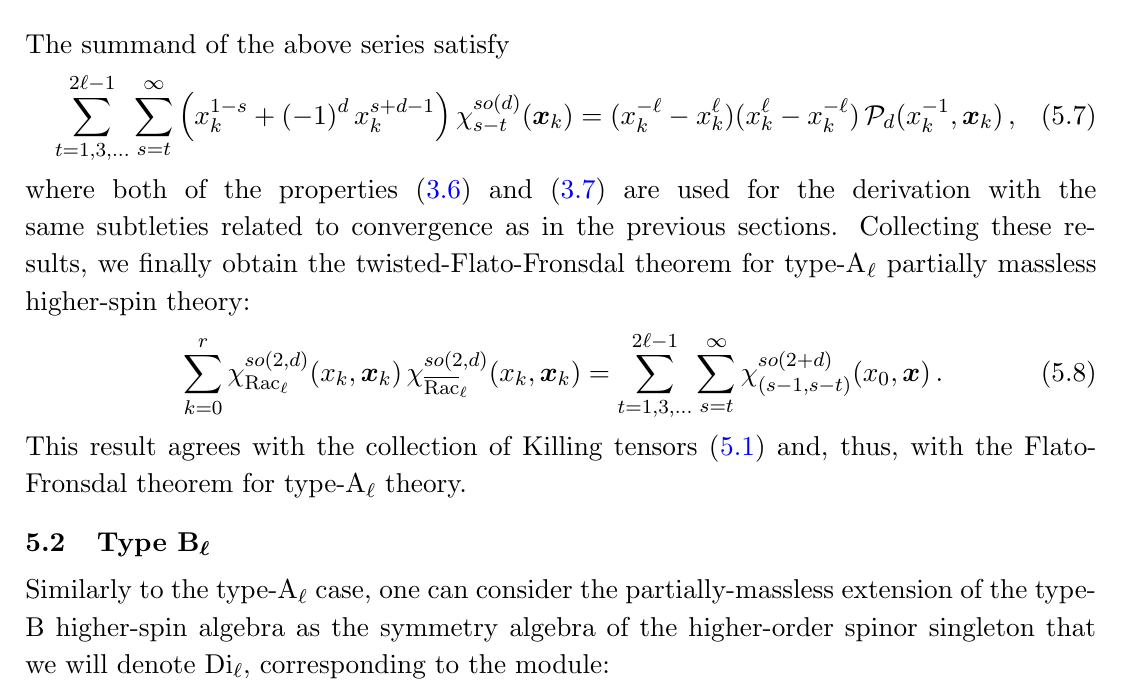
Figure 2 . Weight diagram of the scalar, order ‘ , singleton (blue crosses) and of the scalar, order ‘ , anti-singleton (red